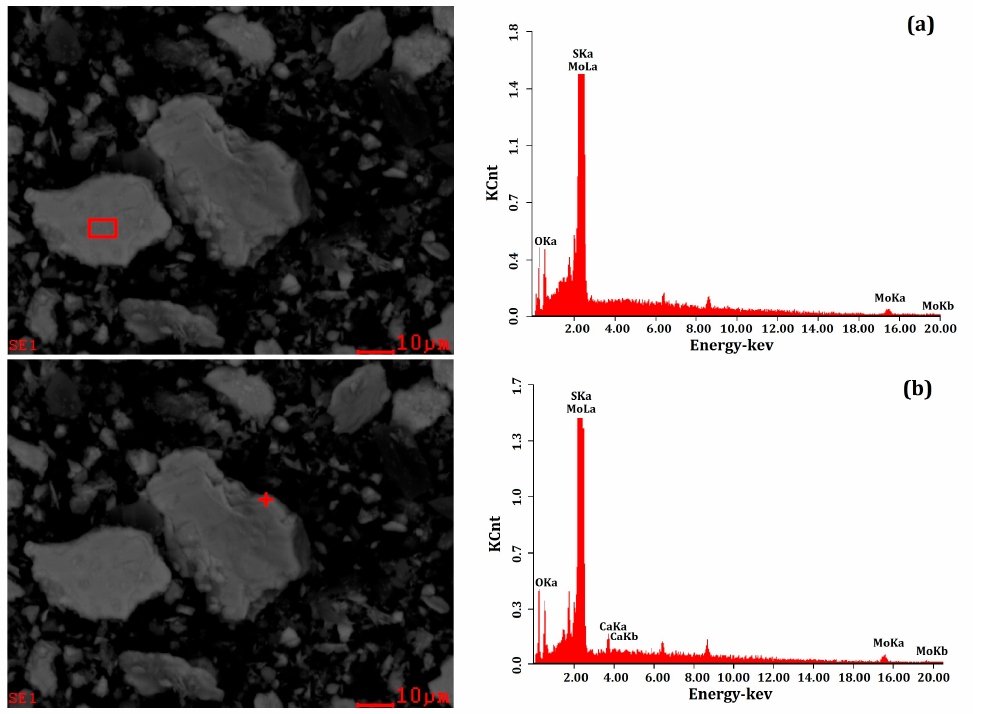
Figure 6. SEM images and EDS analyses of molybdenite faces and edges after treated with 800 mg/L Ca 2+ and 20 mg/L diesel at pH 8: ( a ) SEM images and EDS analyses of molybdenite faces; ( b ) SEM images and EDS analyses of molybdenite edges.